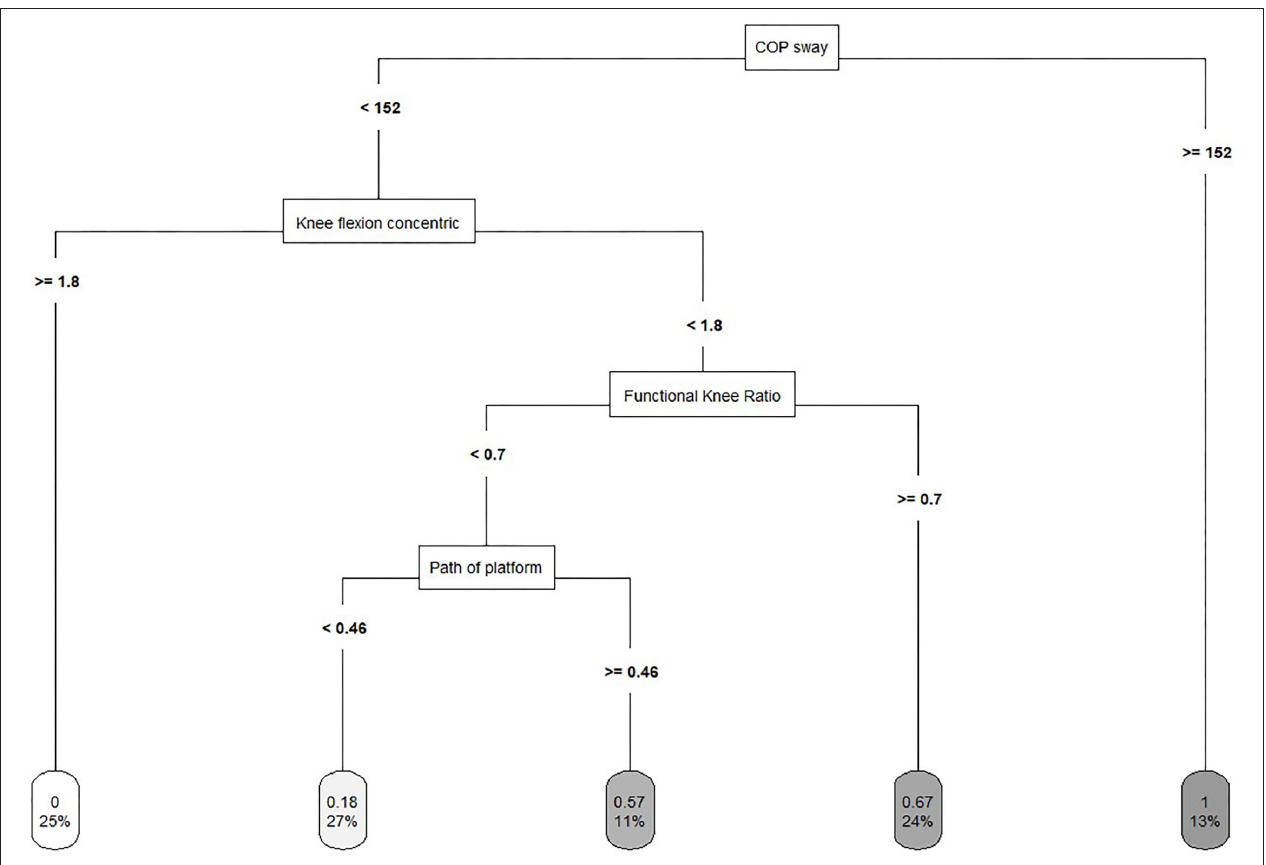
FIGURE 5 | Decision Tree model to discriminate between injured and non-injured players. The lower number in the leaf node indicates the proportion of the sample, whereas the upper number indicates the proportion of the injured players in the